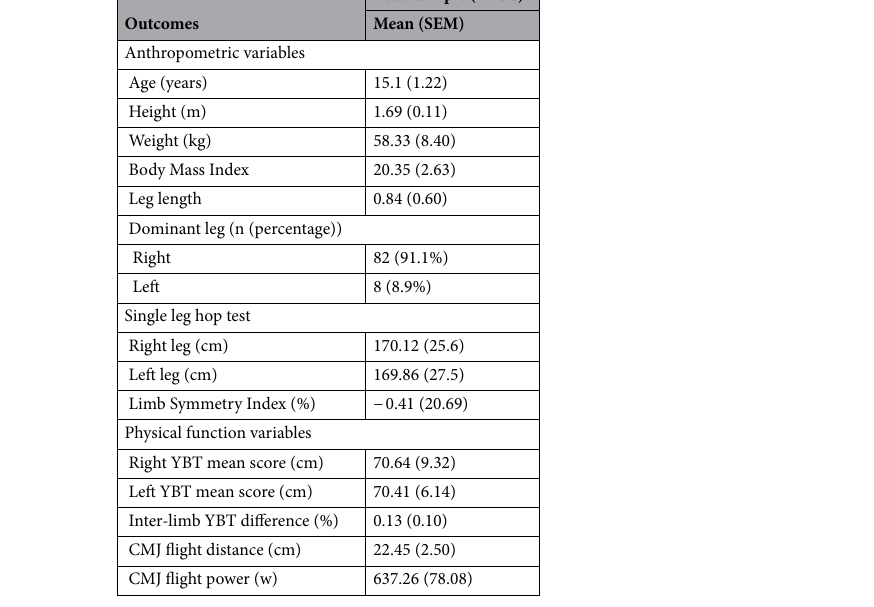
Table 1. Descriptive values for the total sample. YBT: Y Balance Test; CMJ: Counter Movement